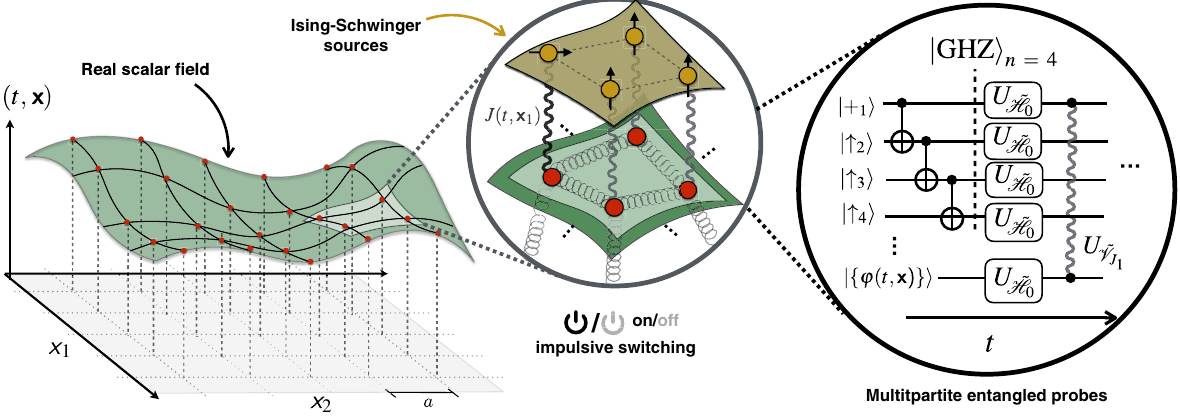
FIG. 1. Scheme of the impulsive sensors for the generating functional: a real scalar field φ( t , x ) is coupled locally by Ising-Schwinger sources of strength J ( t , x ) to an ancillary Ising field, which, in principle, also resides at every space-time point σ ( t , x ) . In practice, the QFT will be regularized on a lattice of spacing a , and the discretized Ising field need only be placed at a reduced set of spatial locations, which can be interpreted as a multipartite sensor. By switching on and off the Ising-Schwinger sources are impulsively, as discussed in the text, one maps the information of the generating functional of the field Z [ J ] onto the Ising spins (see the first inset). The full time evolution, including the initialization of the Ising spins in a multipartite entangled state, can be represented as a quantum circuit (see the second